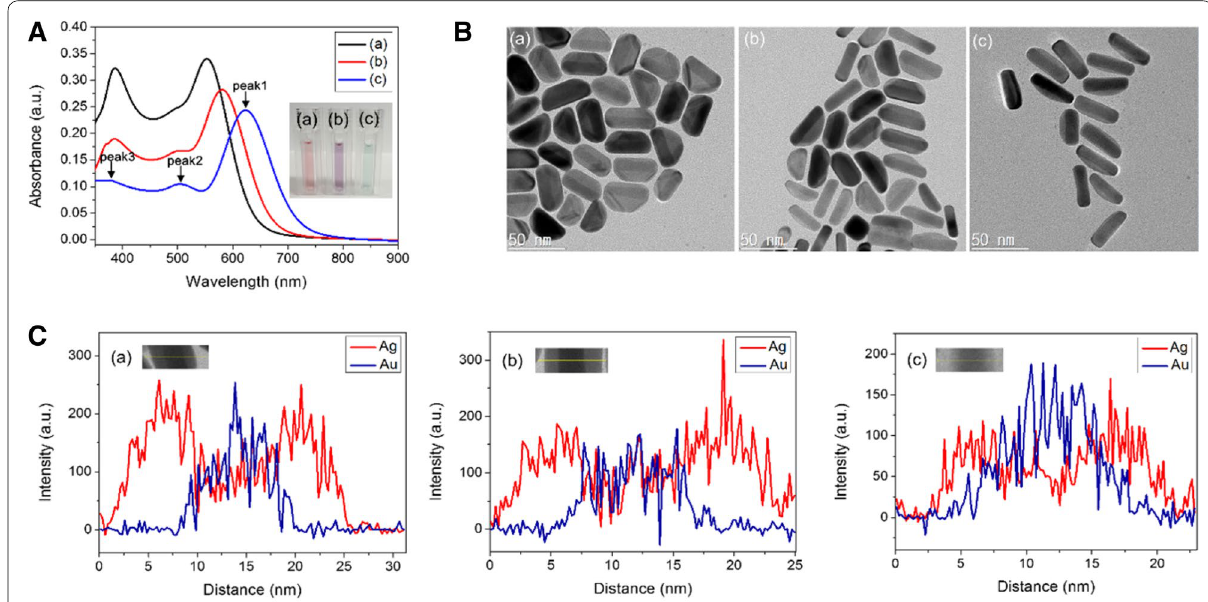
Fig. 2 A UV–vis absorption spectra (Inset: photographs of the AuNR@Ag colloid solutions with different Ag nanoshell thickness), B HR-TEM images and C EDX line-scanning profiles along the line in inset C of AuNR@Ag with different Ag nanoshell thicknesses obtained by changing the amounts of 0.01 M AgNO 3 to a 350 μL, b 250 μL, c 150 μL,